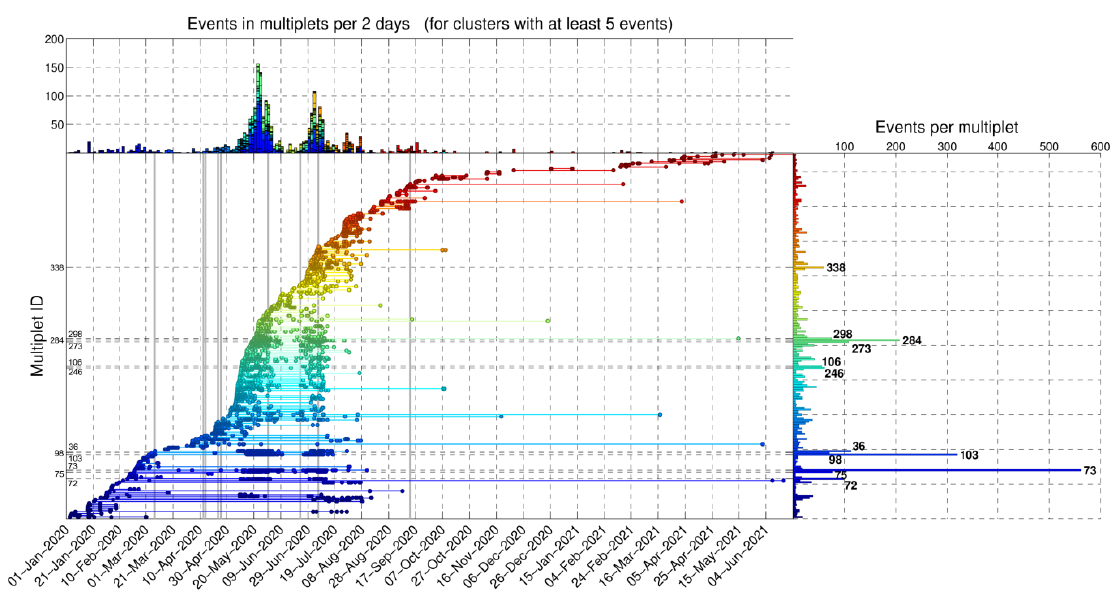
Figure A8. Same as Figure 10, but for CAT2 (templates and single-channel detections on station LTK) with M ≥ −0 .1, as clustered with farthest-neighbor linkage at a threshold of 0.90 between templates and a correlation value of at least 0.75 between templates and detections, after the removal of multiplets, and with less than five events. The multiplet ID of the largest clusters (containing over 50 events with M ≥ −0 .1) is marked in the bottom panels.